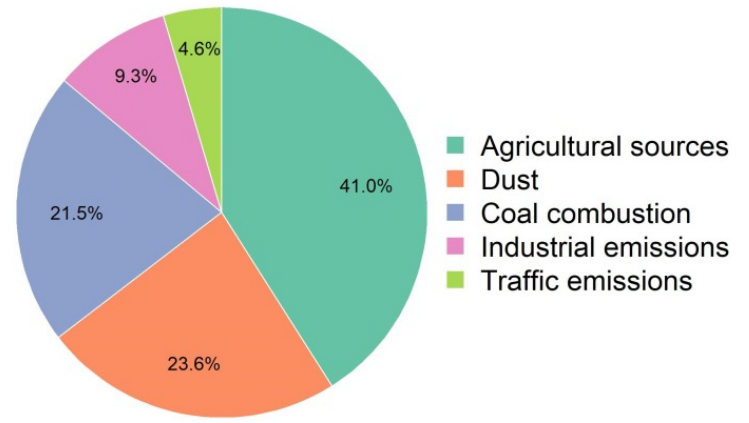
Figure 6. Source contributions resolved from atmospheric depositions at the observation site.